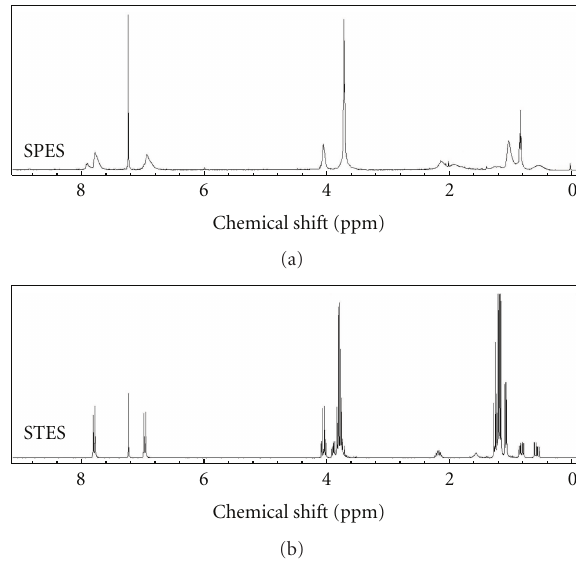
Figure 1: 1 H NMR spectra of STES and SPES (number 2).